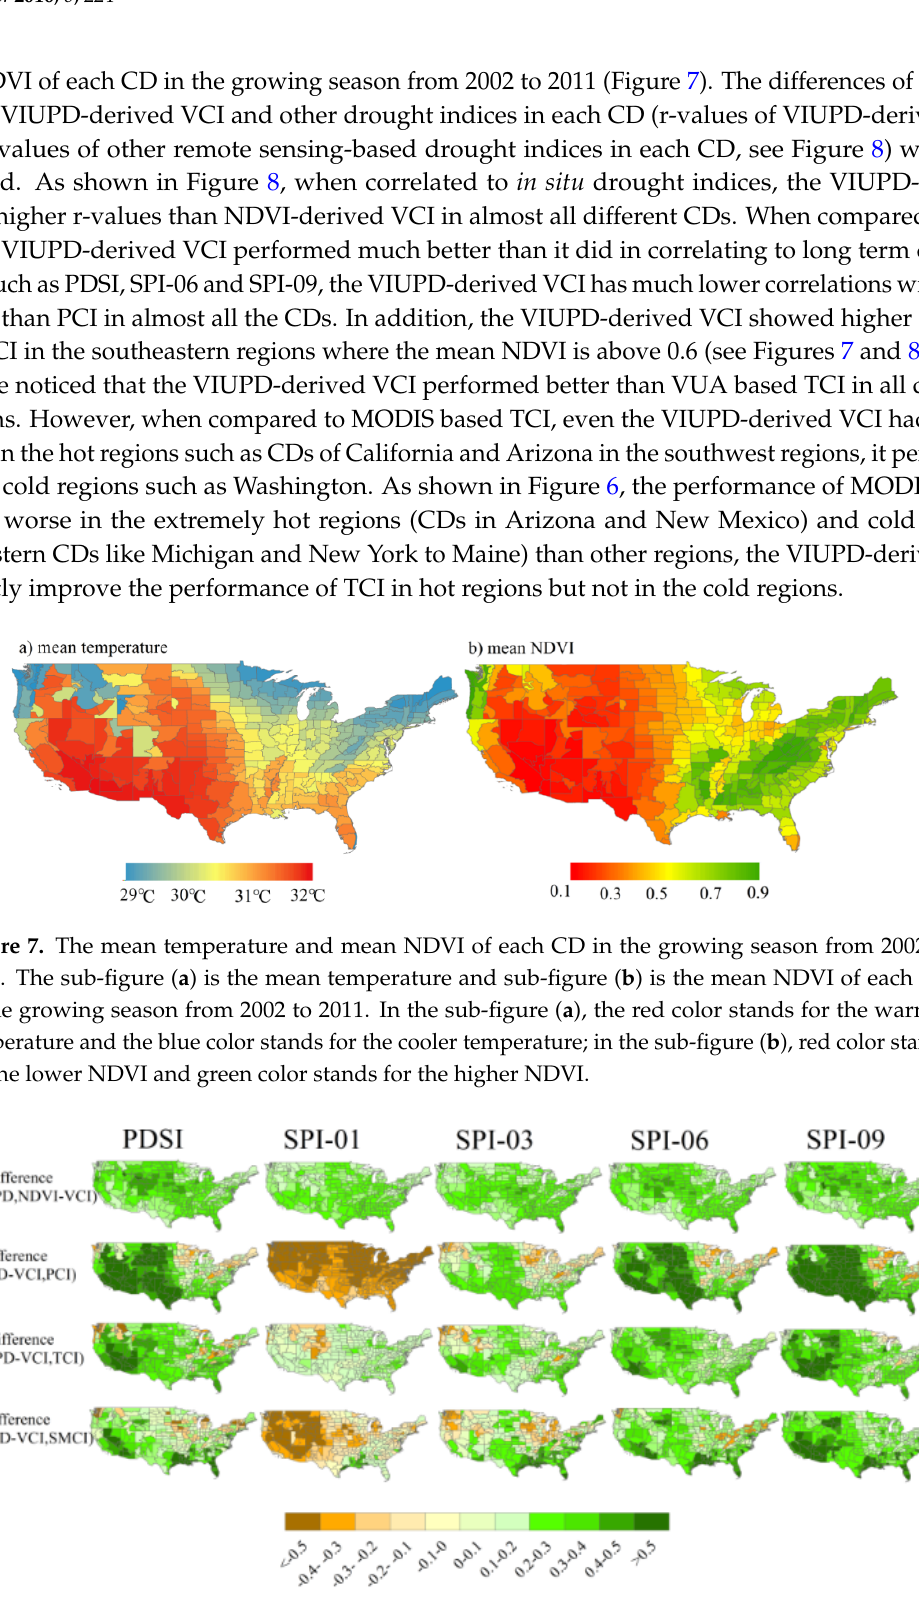
Figure 8. Spatial distribution of climate divisions with correlations (r-value) difference between VIUPD-derived VCI and other commonly used remote-sensing-based drought indices. The difference means the r-value of VIUPD-derived VCI in each CD minus the r-value of other drought indices.